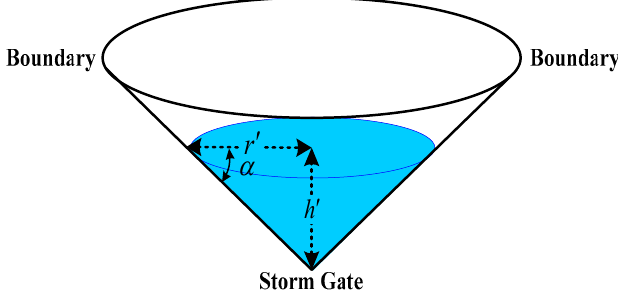
Figure 5. The section diagram of flood inundation in the drainage basin cone.